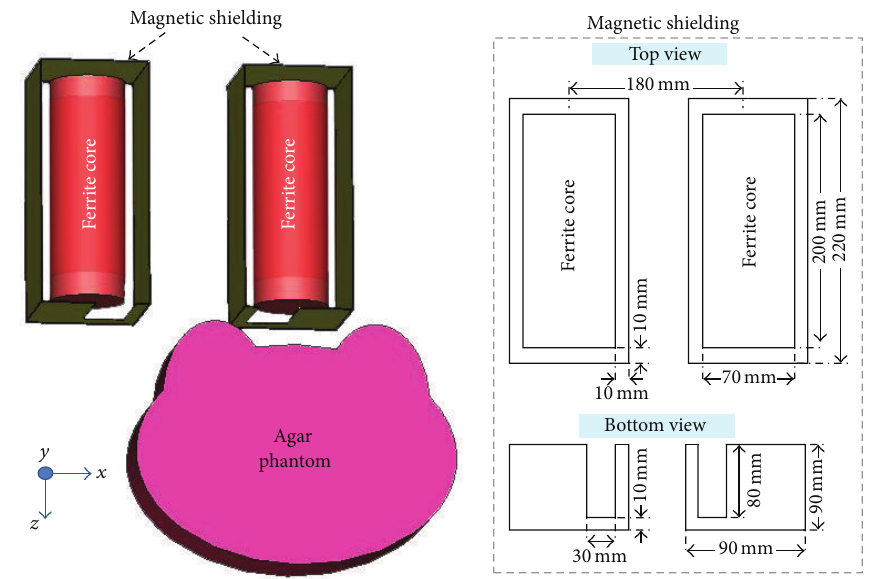
Figure 4: Analytical model of magnetic field shielding system, which represented the parameter details of the ferrite core and magnetic shielding plate for an analysis of electric loss density and temperature